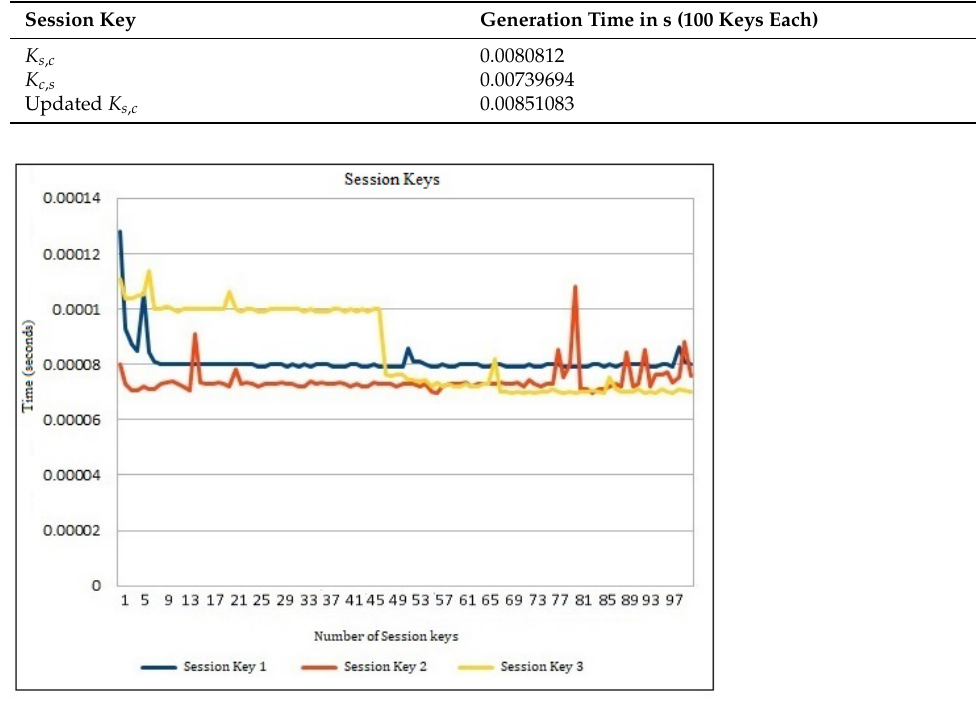
Figure 4. Time generation analysis of session keys.